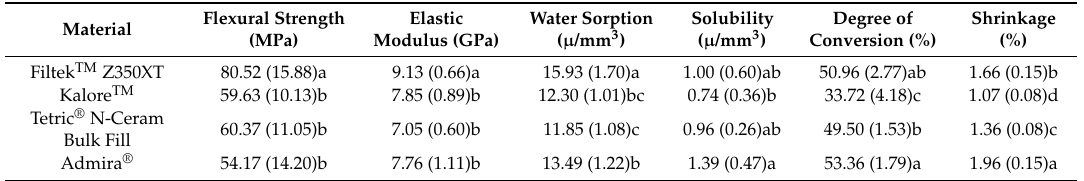
Table 2. The pooled properties of the evaluated resin-based